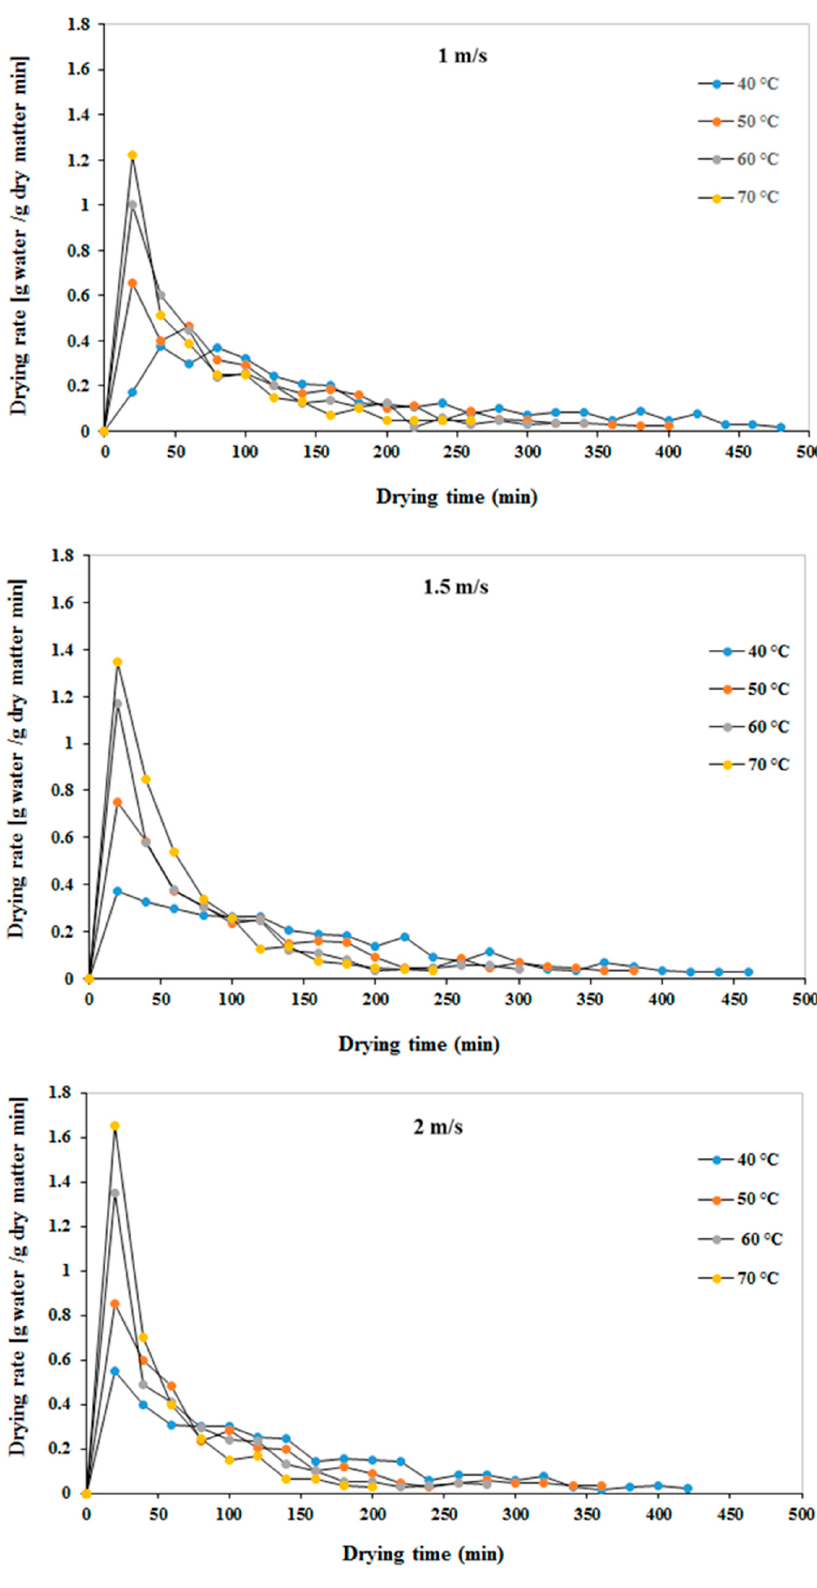
Figure 3. Drying rate of rosemary in different drying conditions.